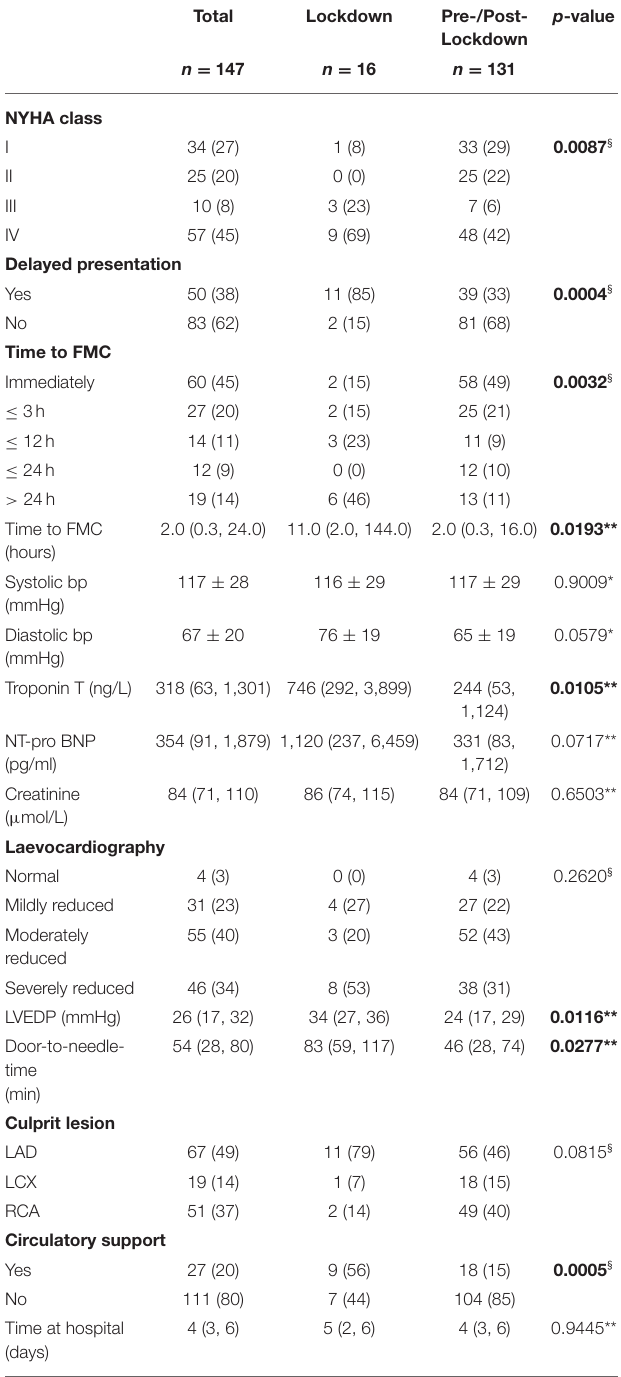
TABLE 2 | Clinical characteristics at